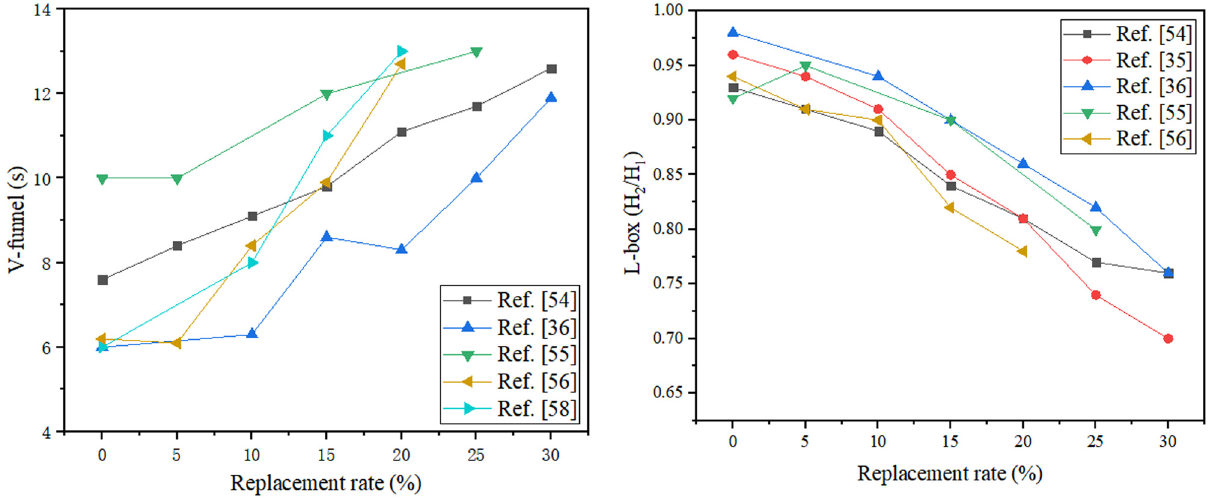
Figure 5: L - box ratio of RHA – SCC [ 35,36,54 – 56 ] .